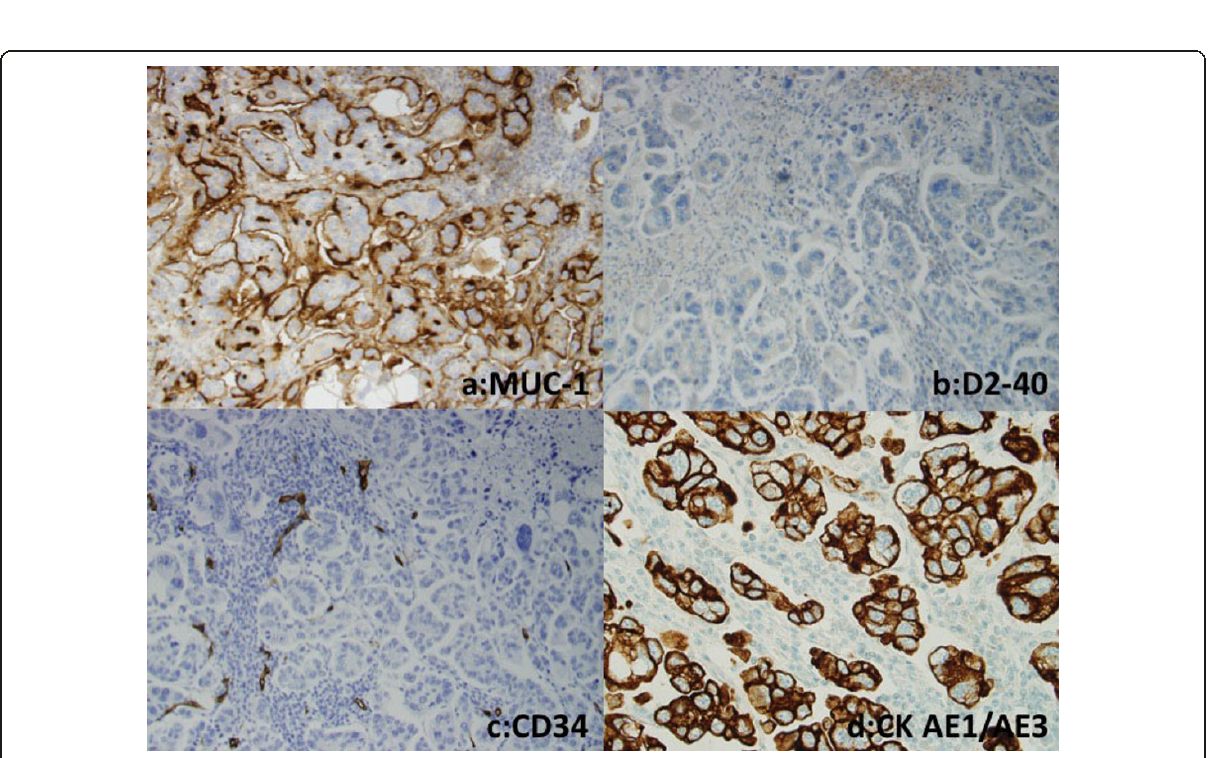
Figure 5 Immunohistochemical photomicrographs of case 1 . (a) Tumor clusters of stromal micropapillary pattern had MUC1 expression on the outer surface strongly, indicating ‘ inside-out ’ pattern. (×200) (b) D2-40 and (c) CD34 were not found in cells consisting micropapillary tufts and (d) CK was not found in connective tissue surrounding the tumor cells. (b, c, ×200; d,